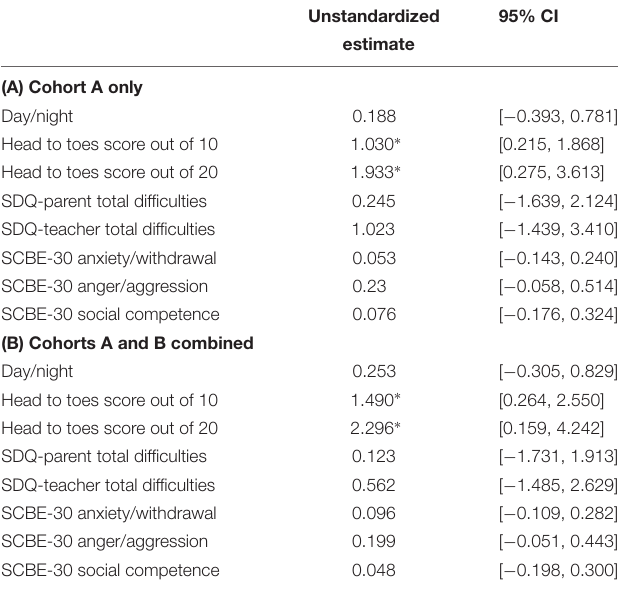
TABLE 5 | Results for effect of curriculum moderated by initial level of hyperactivity/inattention.